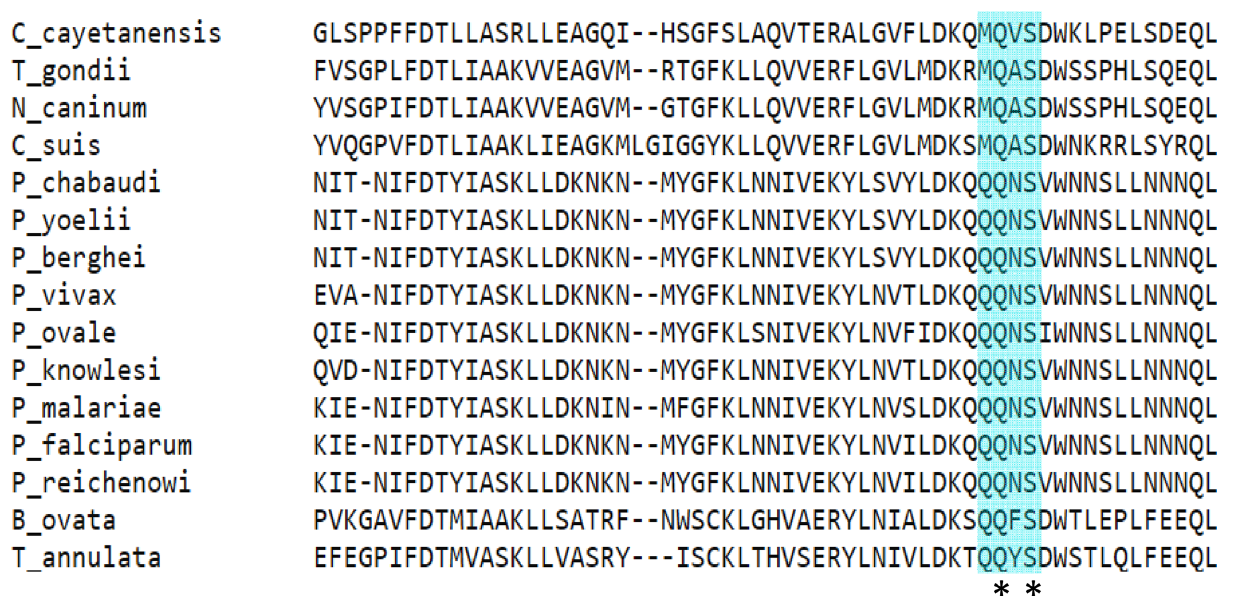
Figure 7. Sequence alignment of DNA Polymerases from different members of apicomplexa. The stretch 1582 QQNS 1585 is highlighted in cyan and the residues marked with an asterisk are conserved across different members of the apicomplexans. The QQNS motif is conserved across different members of the Plasmodium genera. The second Q and the S residues are conserved in many